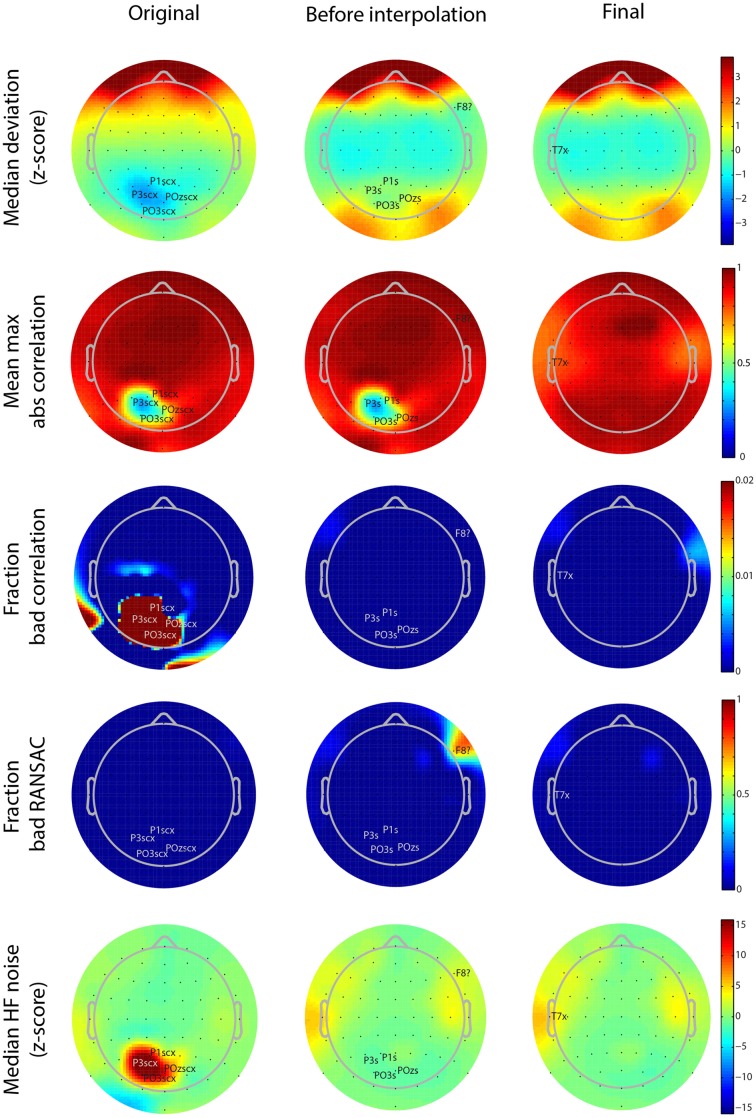
Scalp map visualizations of noisy channel characteristics for a 64-channel Biosemi dataset produced by the PREP reporting facility. Each graph indicates channel positions by dots and labels only those channels found to be bad. In each case the channel label is followed by an indicator of cause (c, correlation, x, noise, ?, RANSAC, s, low SNR). The three columns correspond to the three stages in the robust reference procedure (original signal, after reference but before interpolation, and final). Each row corresponds to a different measure (see text). Color scales are consistent across the rows.